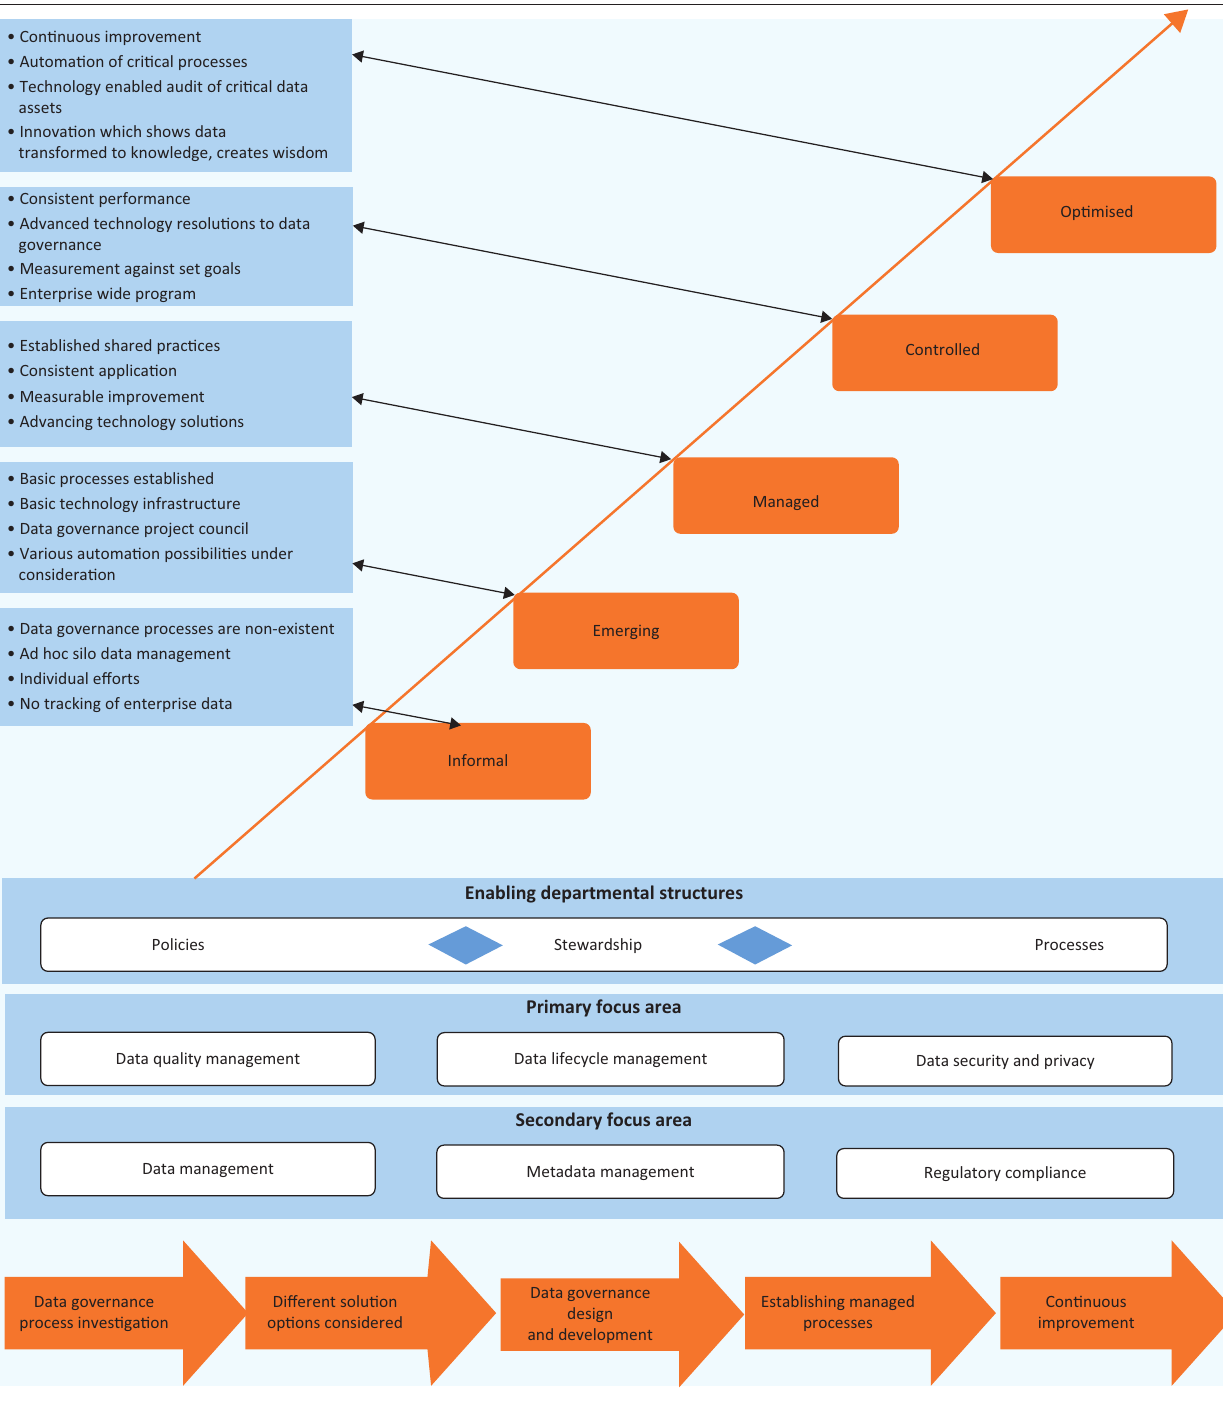
FIGURE 1: The Data Governance Maturity Evaluation